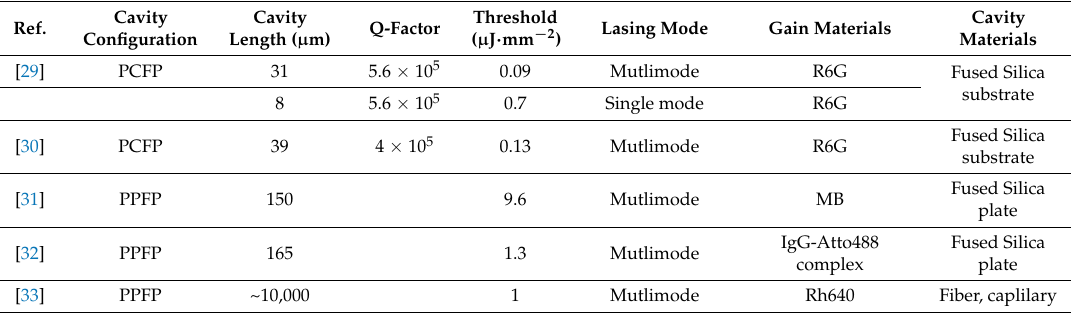
Table 1. List of the optofluidic lasers based on the Fabry–P é rot microcavities. Ref.